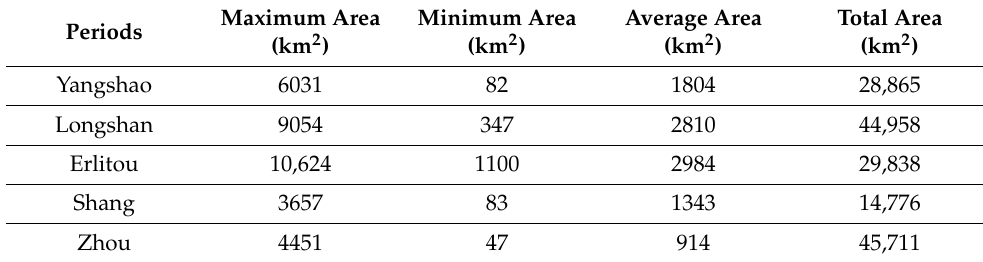
Table 4. Thiessen polygon analysis